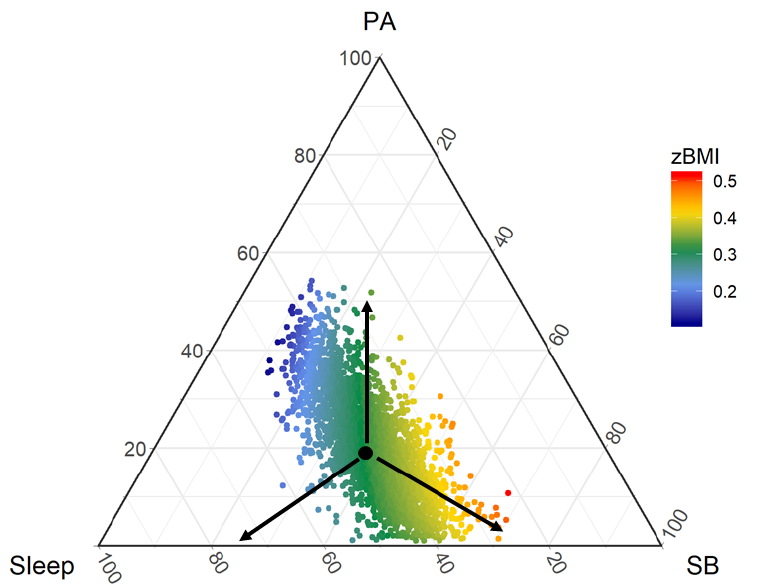
Figure 4. Estimated zBMI response surface. Arrows indicate reallocation of time to the part in the corner, taking it equally from the remaining parts. PA = physical activity; SB = sedentary behavior; zBMI = estimated body mass index z-score.